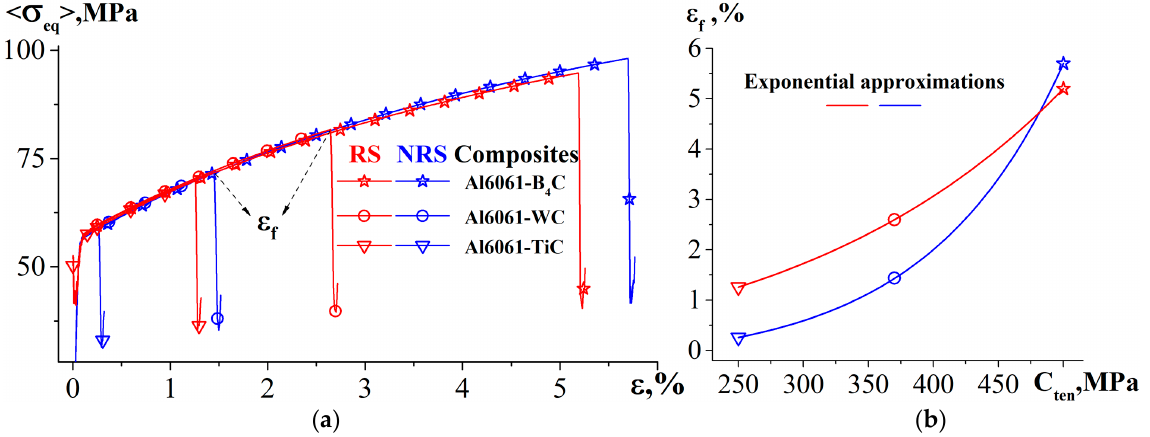
Figure 14. Stress–strain curves under tension (NRS) and tension after cooling (RS) of the composites with different particle materials and an Al6061 matrix ( a ). Corresponding elongation of composites at the fracture onset vs. particle strength ( b ).